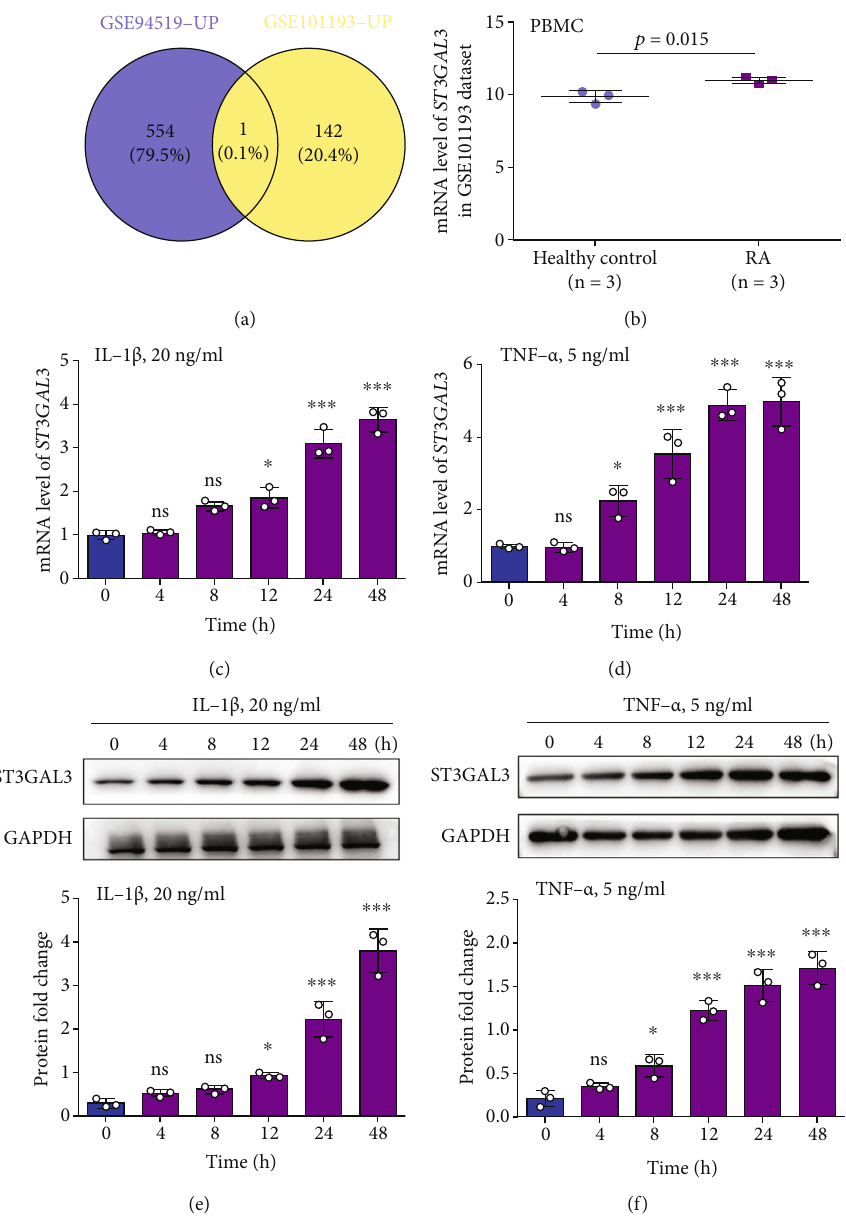
Figure 1: ST3GAL3 was upregulated in RA tissues and cell lines. (a) ST3GAL3 was an overlapping gene screened from GSE101193 and GSE94519 datasets. (b) ST3GAL3 was signi fi cantly highly expressed in the PBMCs of RA patients in contrast to normal controls in GSE101193 dataset. (c, d) The qRT-PCR and (e, f) western blotting results showed that the expression of ST3GAL3 was increased with prolonged IL-1 β and TNF- α treatments in MH7A cells. n = 3 . ns: no signi fi cance; ∗ p < 0 : 05 and ∗∗∗ p < 0 : 001 compared with the expression of ST3GAL3 at